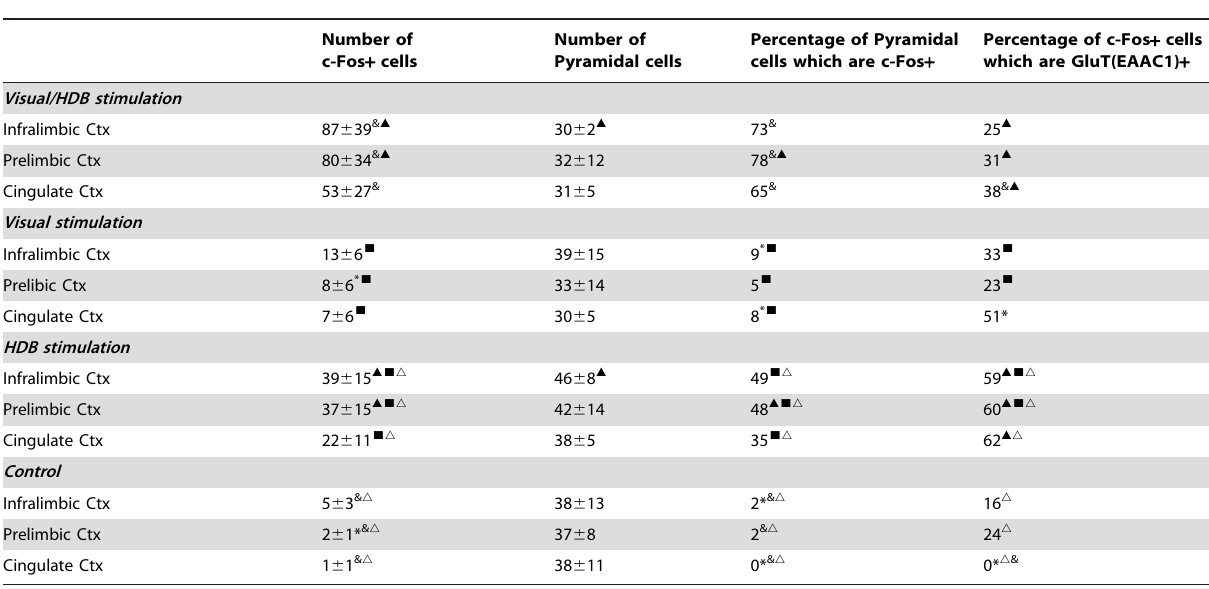
Table 2. Number of c-Fos + cells and Pyramidal cells in layer V of mPFC.